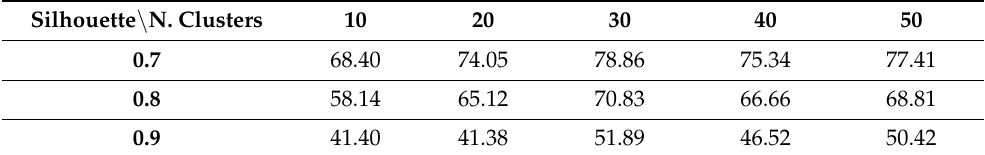
Table 44. Clustering performance in terms of silhouettes using the reduced dataset with PCA. Silhouette \ N. Clusters